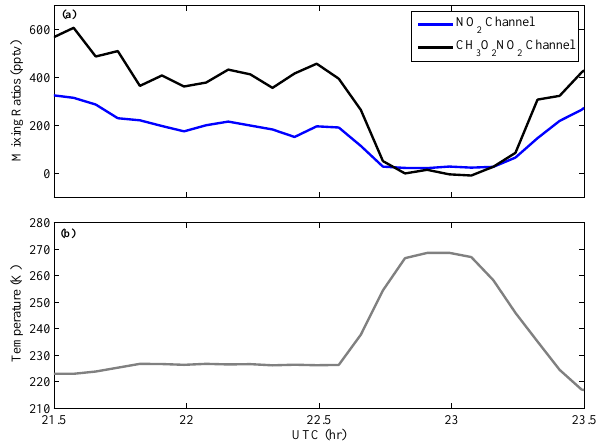
Figure 6. Five-minute-averaged time series of (a) NO 2 (blue) and CH 3 O 2 NO 2 (black) channel and (b) temperature from a flight on 17 June 2012 during DC-3. The local time was approximately midafternoon during this time